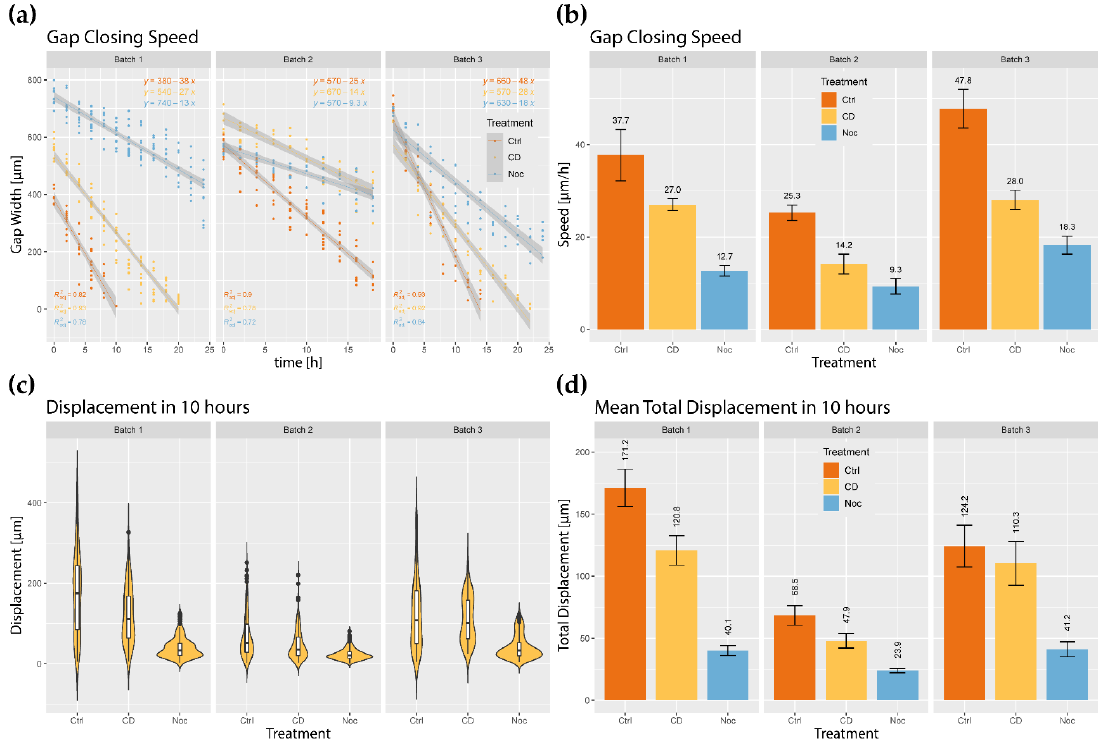
Figure 3. ( a ) Linear regressions of collected gap distance data at increasing time points for cytoskel ‐ etal disruptions (Ctrl—control; CD—50 ng/mL cytochalasin D; Noc—50 ng/mL nocodazole). The slope of the linear regression is the gap closing speed; ( b ) Gap closing speeds comparing cytoskeletal disruptions, with the bars representing the respective 95% confidence interval; ( c ) Violin plot of EC 10 ‐ h displacements under different cytoskeletal disruptions in a wound healing assay; ( d ) Mean displacement in 10 h. The error bars correspond to the 95% confidence interval. Tying in the large ‐ scale behavior of gap closing speed and individual cell migration, the box and violin plots present the displacement distribution of ECs (Figure 3). Control and actin ‐ disrupted wound healing models displayed a higher maximum displacement, while tubulin ‐ disrupted monolayers had a bias toward no displacement. From the distri ‐ bution, the mean total displacement was calculated. Actin ‐ disrupted cells produced sig ‐ nificantly lower mean total displacement compared to the control, whereas tubulin ‐ dis ‐ rupted monolayers displayed a decrease in mean displacement compared to the control monolayers (Figure 3d). From both the full field of view and 4 X zoom ‐ in, qualitative differences in cell morphol ‐ ogy can be identified (Figure 2). Control HUVECs appear oblate with clear definition in their stress fibers. Notably, the control monolayers appear simply connected, meaning that no holes are found in the gap ‐ separated monolayers (Figure 2). After disrupting actin polymerization, irregular morphology can be identified, and the existing actin appears concentrated at the cell periphery (Figure 2). At the 10 ‐ h mark, the actin ‐ disrupted monolayer is no longer simply connected—numerous instances of cell–cell connectivity loss are identified (Figure 2). Tubu ‐ lin ‐ disrupted cells appear with more subtle changes. Firstly, the individual ECs appear less oblate, and instances of cell connectivity loss are identified (Figure 2).